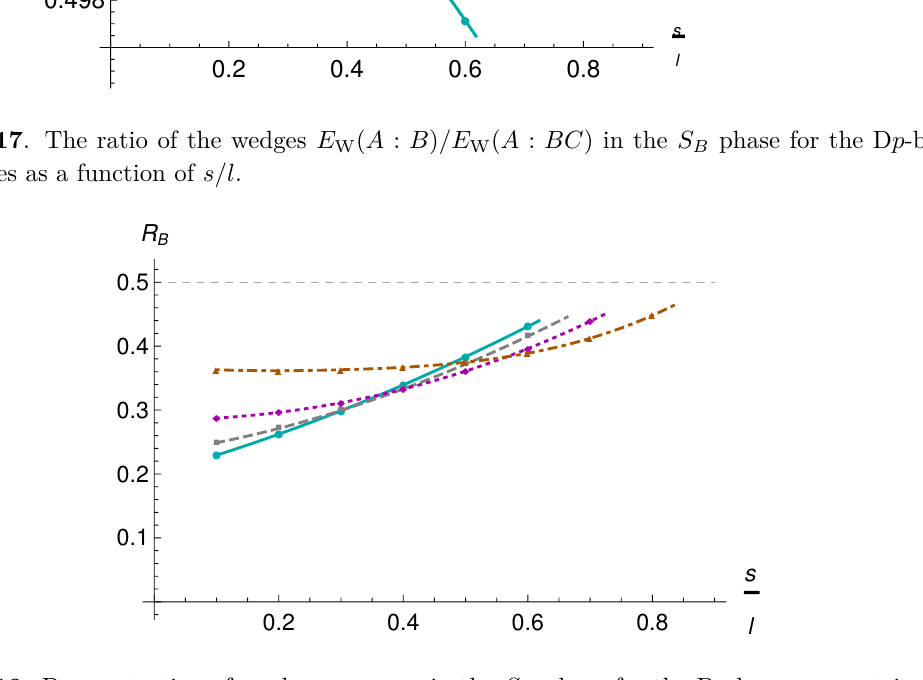
Figure 18 . Demonstration of weak monogamy in the S B phase for the D p -brane geometries as a function of s/l . Notation is similar to figure